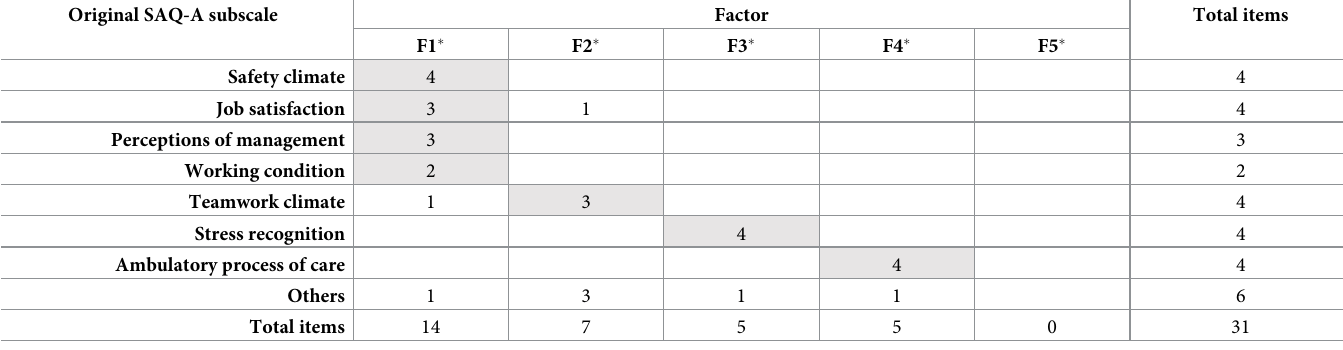
Blank cells represent 0